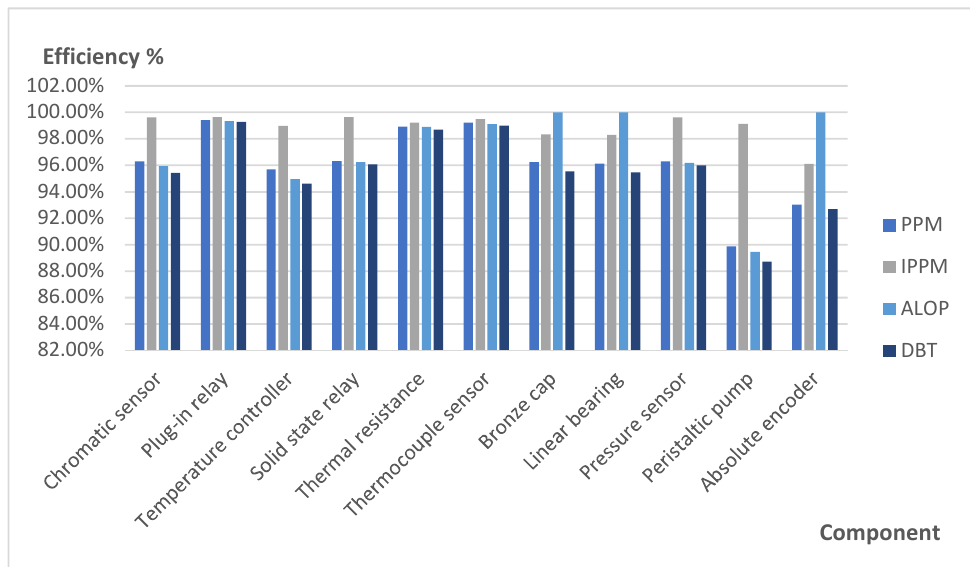
Figure 8. Comparison of efficiency values in affected components.